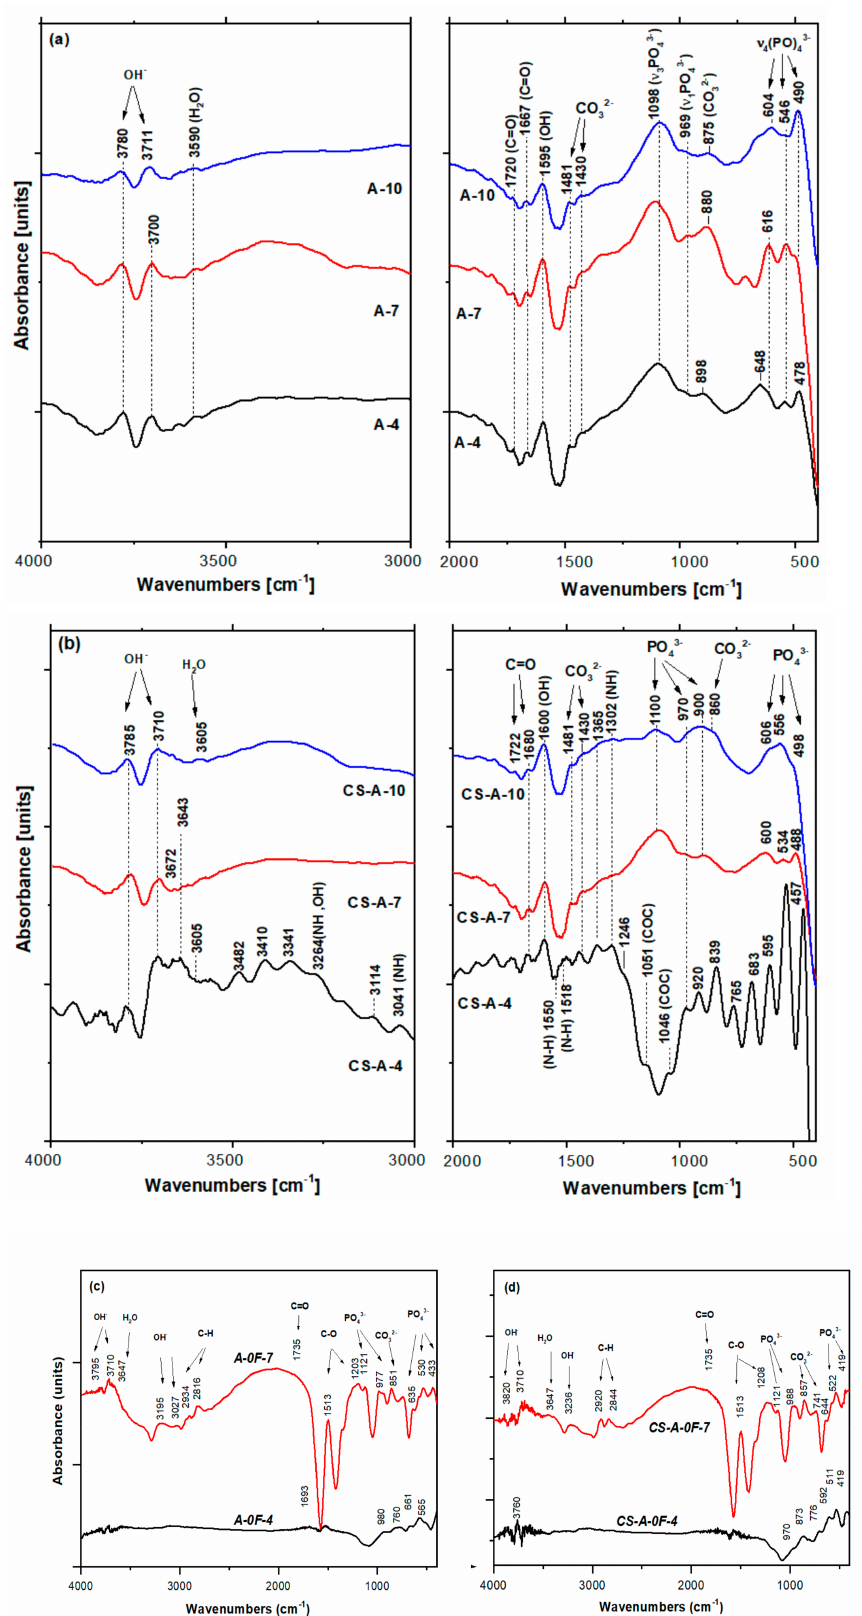
Figure 9. FTIR spectra of remineralized samples: ( a ) A-(4/7/10), ( b ) CS-A-(4/7/10), ( c ) A-0F-(4/7), and ( d )